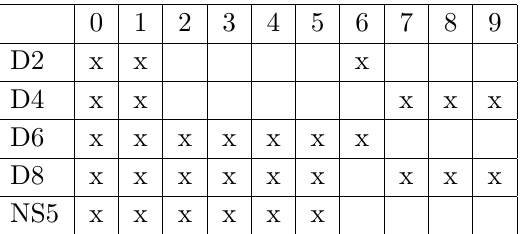
Table 1 . 1 -BPS brane intersection underlying our geometry. The directions ( x 0 ; x 1 ) are the 8 directions where the 2d CFT lives (dual to our AdS 3 ). The directions ( x 2 ; : : : ; x 5 ) span the CY 2 , on which the D6 and the D8-branes are wrapped. The coordinate x 6 is the direction associated with (cid:26) . Finally ( x 7 ; x 8 ; x 9 ) are the transverse directions realising an SO(3)-symmetry associated with the isometries of S 2